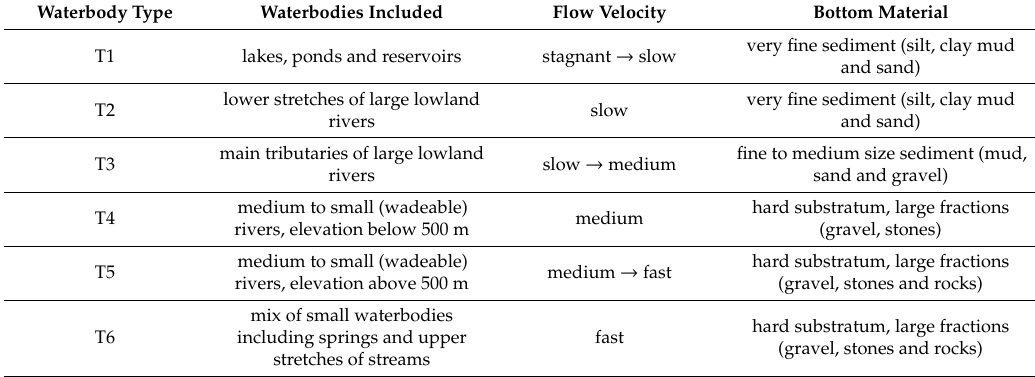
Table 1. Waterbody types and their characteristics (flow velocity and bottom